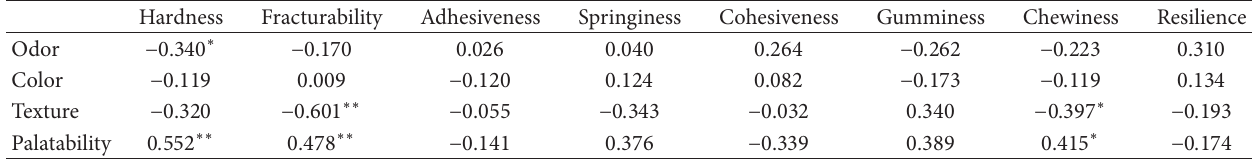
Table 6: The correlation between sensory evaluation and TPA